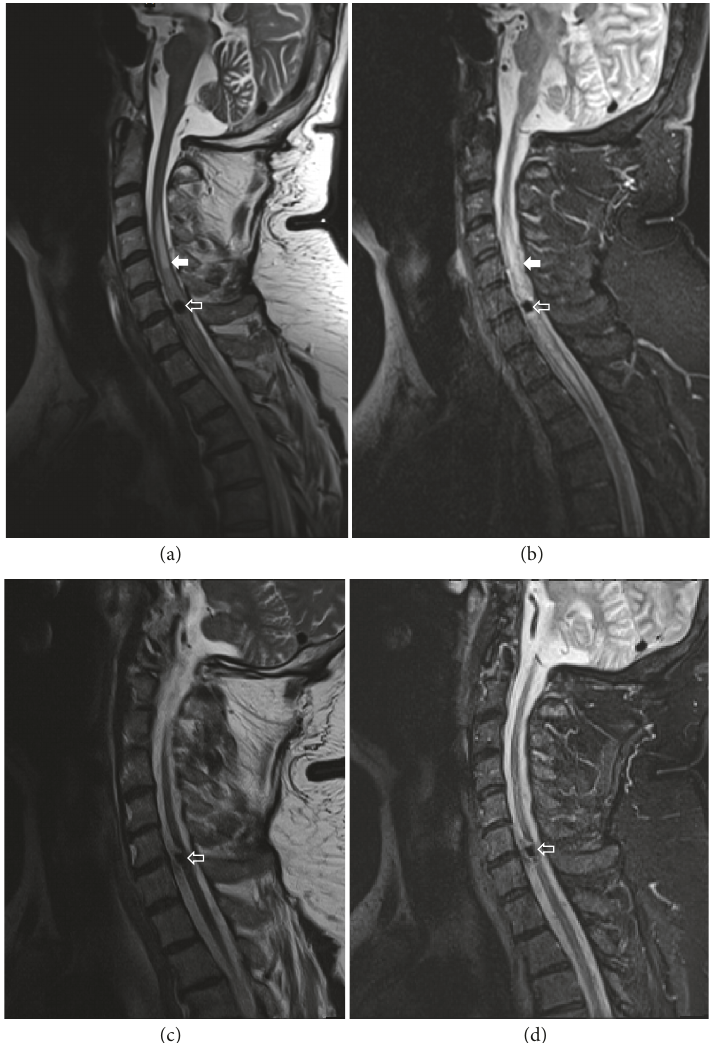
Figure 1: MRI of the cervical spine: initial MRI at symptom onset : (a) sagittal T2W/TSE (TR 3800 ms, TE 108 ms); (b) sagittal T2W/STIR (TR 4000 ms, TE 39 ms). Images show a hypointense oblong lesion in the spinal cord at the level of C6-C7 (empty arrows). Above and below the lesion the spinal cord shows hyperintense signal consistent with myelitis (filled arrows). Follow-up MRI 10 months later : (c) sagittal T2W/TSE (TR 3800 ms, TE 108 ms) and (d) sagittal T2W/STIR (TR 4000 ms, TE 39 ms). Follow-up images show normal spinal cord appearance following the resolution of myelitis and the same hypointense glass lesion (empty